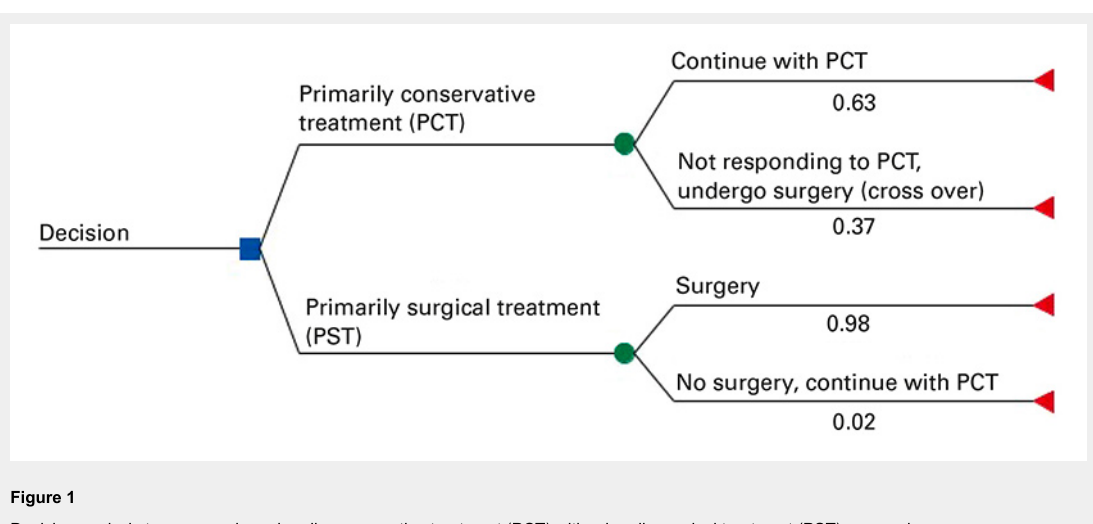
Decision analysis tree comparing primarily conservative treatment (PCT) with primarily surgical treatment (PST) approach.